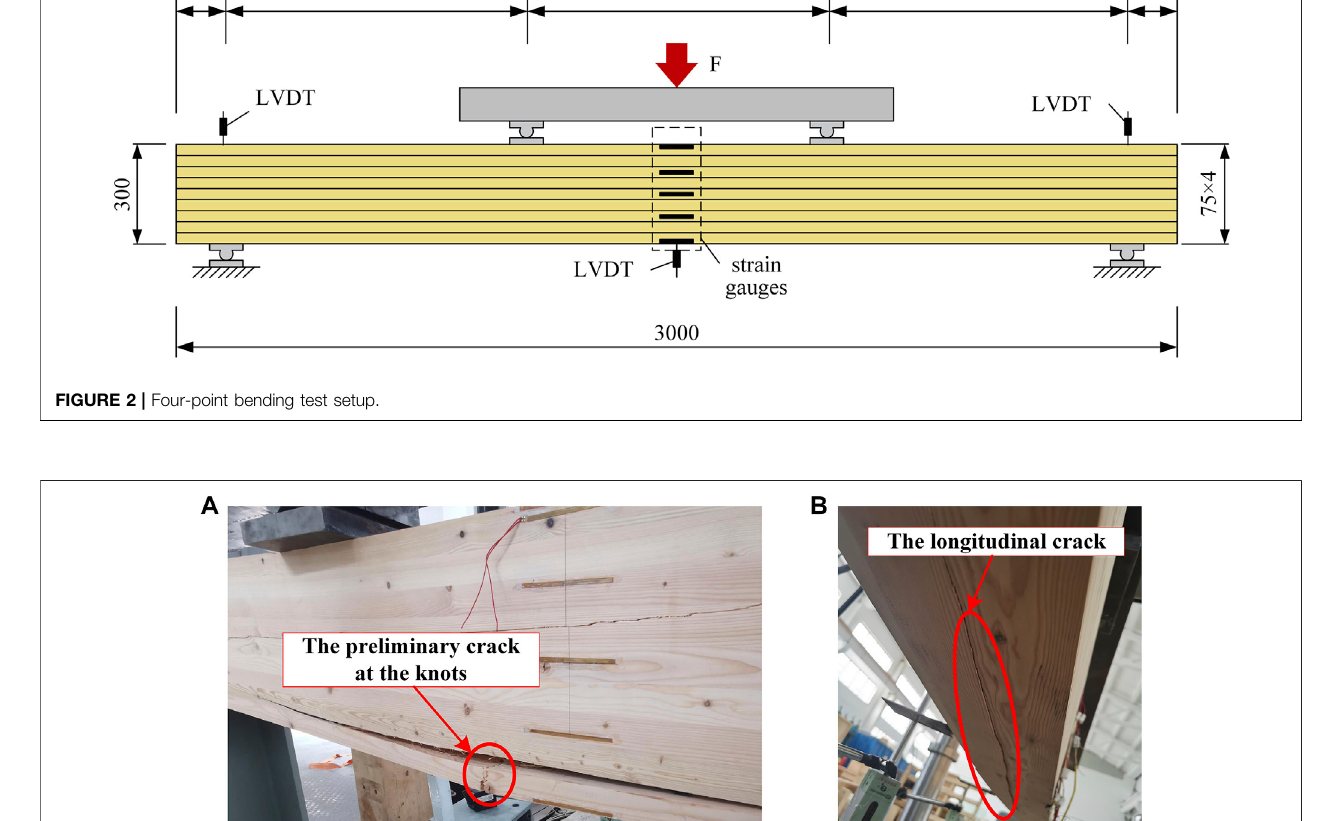
Frontiers in Materials |